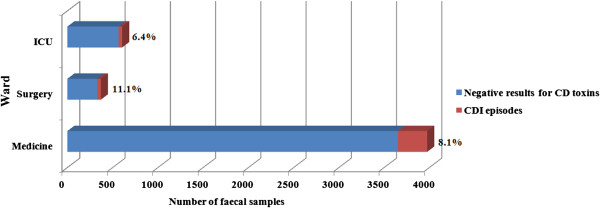
Clostridium difficile infection (CDI) proportion by stool samples assayed by ward.